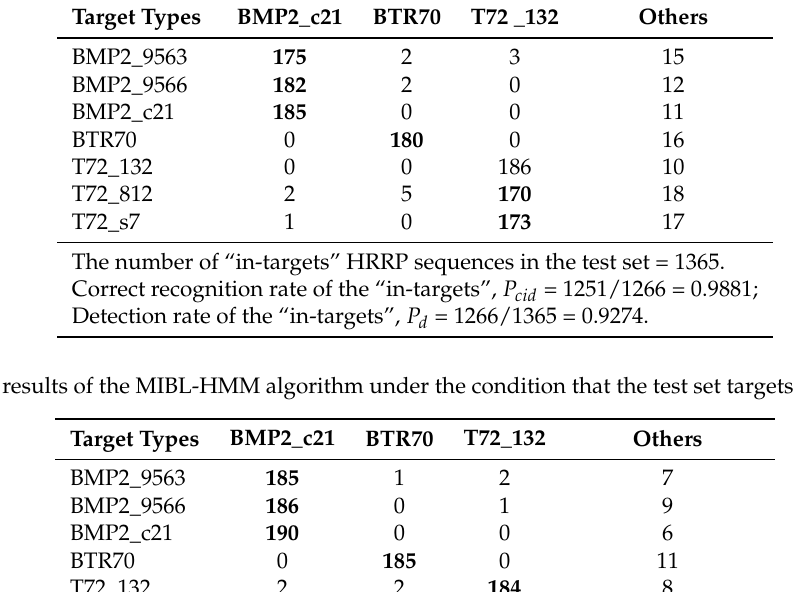
Table 8. Test results of the MIBL-softmax algorithm under the condition that test set targets are “in-targets”. Target Types